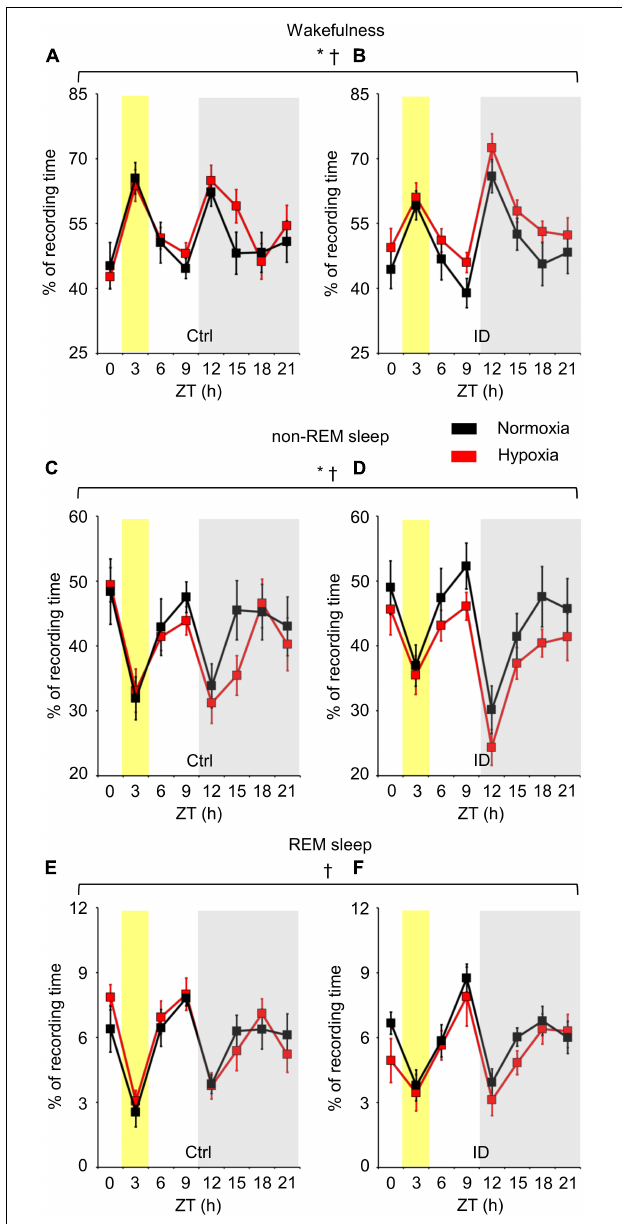
FIGURE 2 | Percentages of recording time spent in wakefulness (A,B) , non-rapid-eye-movement (non-REM) sleep (C,D) , and rapid-eye-movement (REM) sleep (E,F) , averaged every 3 h in mice fed control diet (Ctrl) or iron-deficient diet (ID) during normoxia (black) and hypoxia (red). Zeitgeber time (ZT) 0 is time at lights on. The gray shading indicates the period with lights off (dark period). The yellow shading indicates the 3-h bin including ZT 3, when mice were first transferred to the recording environment. Data are means ± SEM with n = 11 per group. ∗ and † , P < 0.05, main effects of hypoxia and ZT, respectively